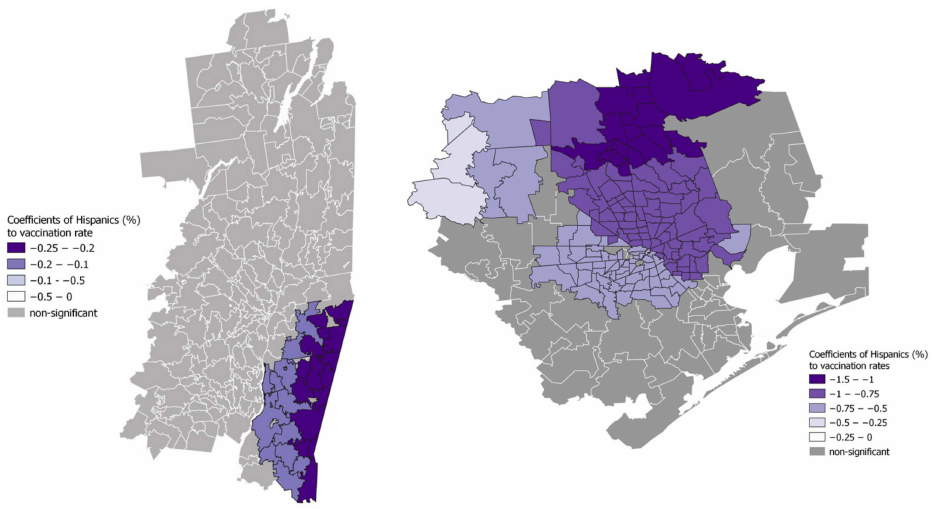
Figure 4. Local coefficients of Hispanic population (%) with regard to vaccination rates as obtained using geographically weighted regression